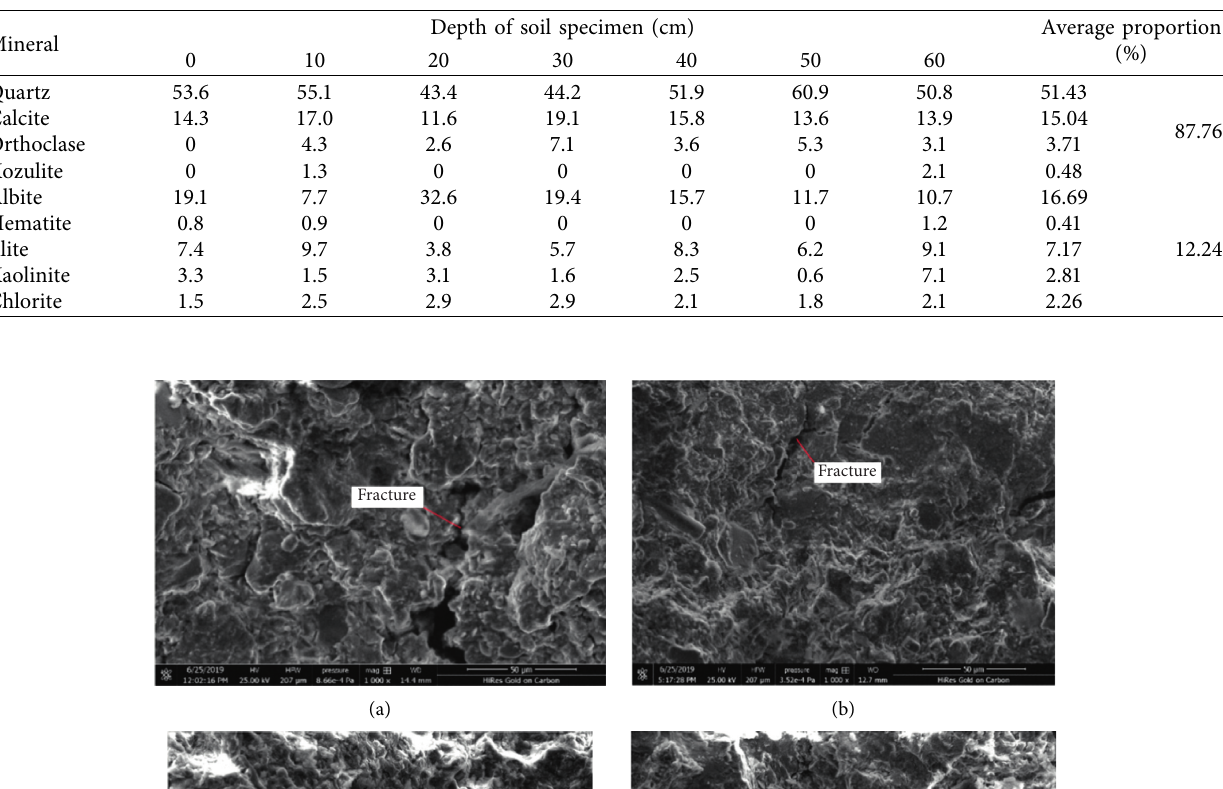
Table 4: Proportions of minerals of the local saline-alkali soil